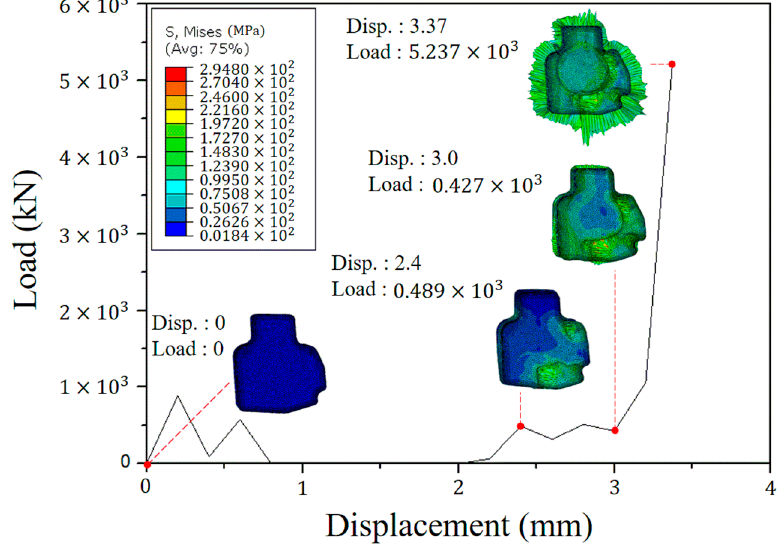
Figure 13. Load–displacement curve obtained by simulation result of warm forging.